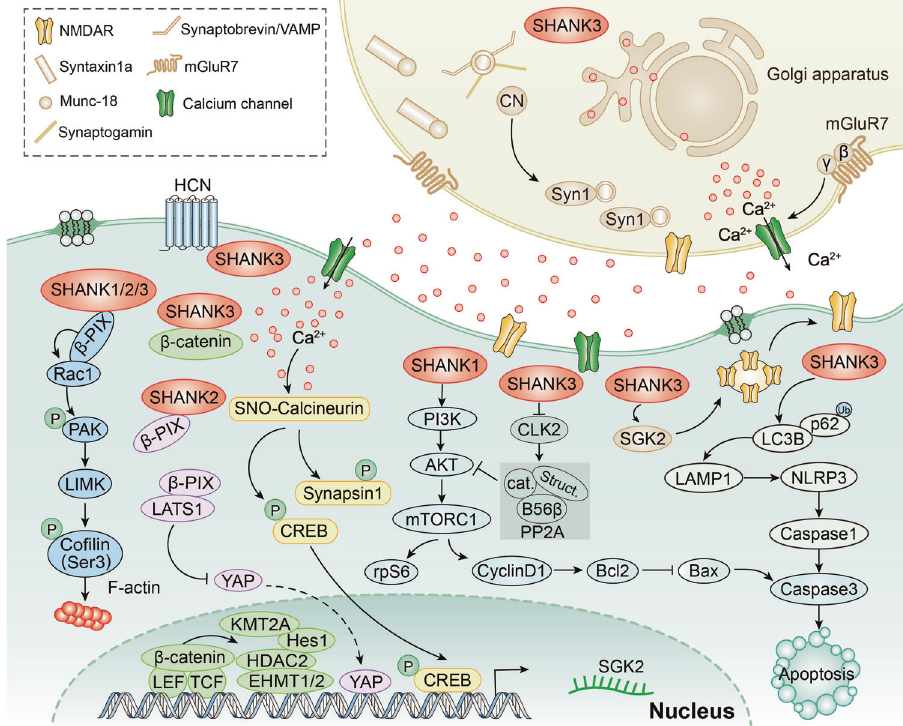
Fig. 4 Schematic diagram of SHANK in the management of signaling pathways. SHANK3 can interact with HCN proteins and also form a complex with β -PIX, which regulates the activity of Rac1/PAK and Co fi lin. Furthermore, SHANK3 can bind to β -catenin to regulate HDAC2, EHMT1/2 and KMT2A. In addition, SHANK3 can in fl uence the balance of Ca 2 + homeostasis, thereby resulting in changes in the phosphorylation of Synapsin1 and CREB. SHANK3 also can modulate the expression of SGK2 and the expressions of several genes associated with autophagy and in fl ammation, including LC3B, LAMP1, NLRP3 and Caspase1. SHANK3 can in fl uence the phosphorylation and activation of PP2A regulatory subunit-B56 β and regulation of mTORC1 signaling by regulating CLK2 expression. SHANK2 can regulate the expression of YAP through modulating the interaction between β -PIX and LATS1. SHANK1 can regulate AKT/mTOR to modulate the expression of Bcl2, Bax and Caspase3.